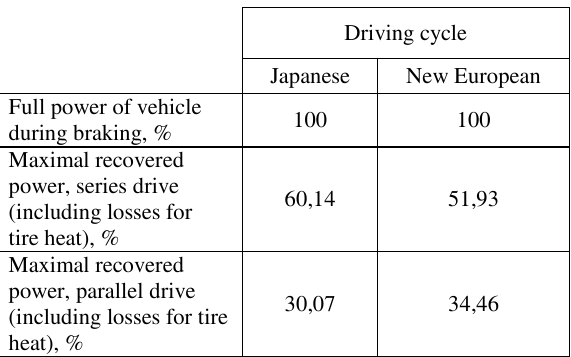
Table 2. Results of modeling